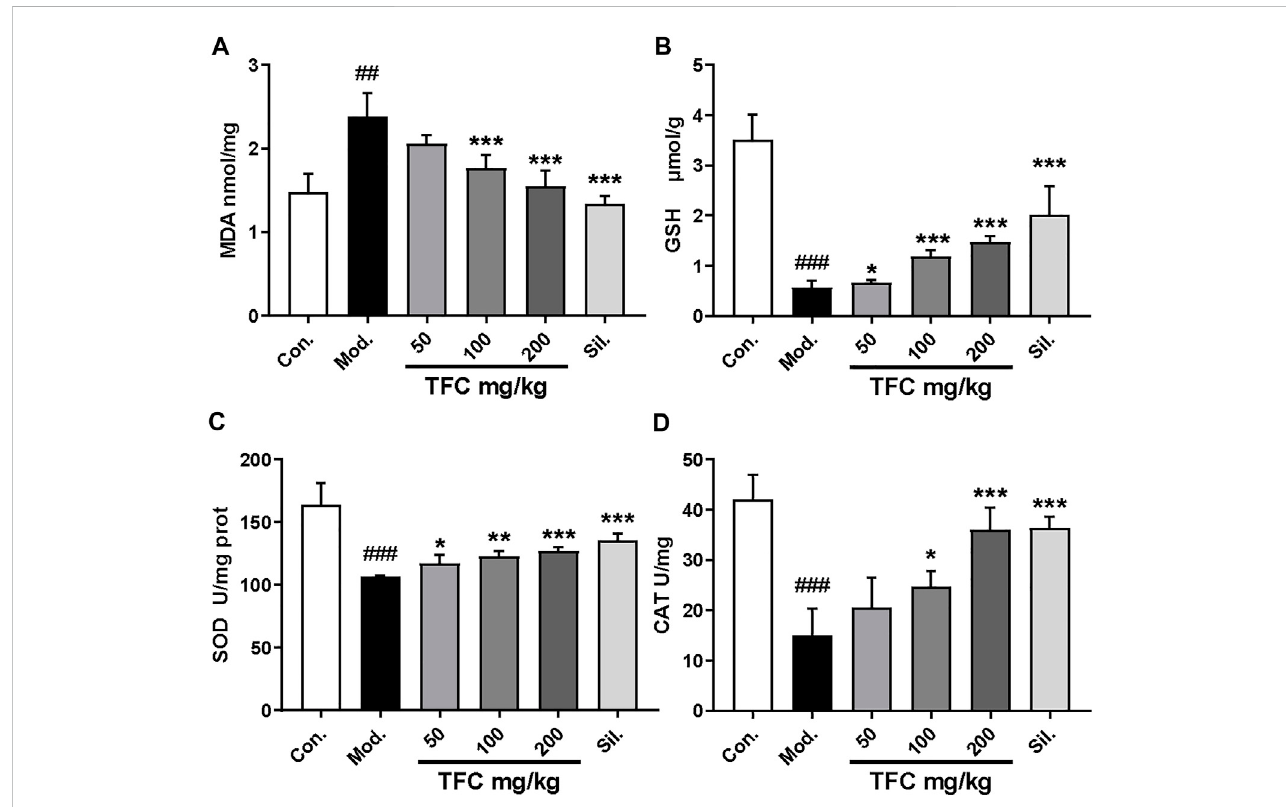
FIGURE 4 TFCenhanced antioxidantcapacitiesinALDrat.Hepaticlevels ofMDA (A) ;GSH (B) ;SOD (C) ;CAT (D) .Dataareexpressedas mean±S.D. # p < 0.05, ## p < 0.01, ### p < 0.001 vs. control group; * p < 0.05, **p < 0.01, ***p < 0.001vs. model